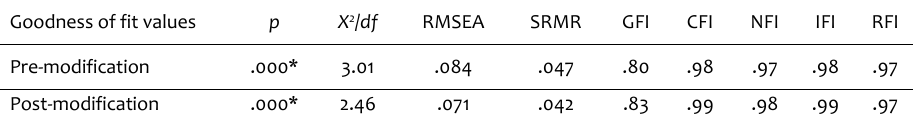
Table 2: Confirmatory Factor Analysis Results Goodness of fit values